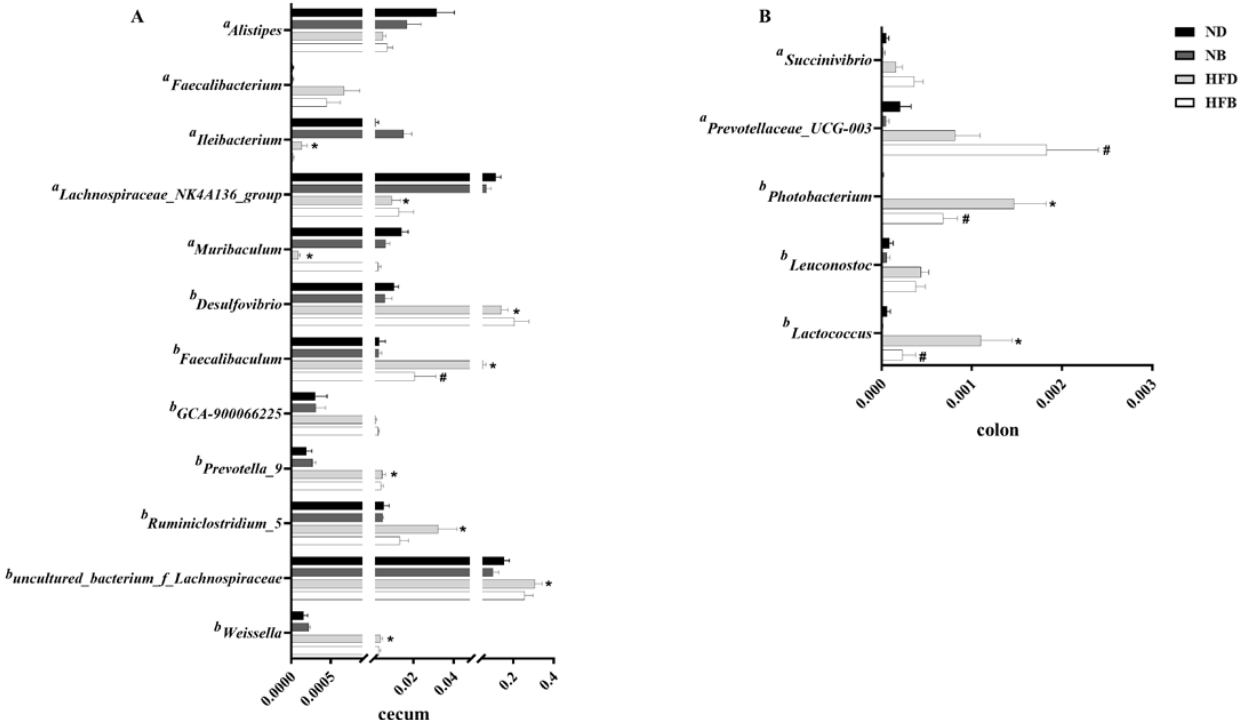
Figure 7. BCAA supplementation alters gut microbiota relative abundance in ApoE − / − mice. The relative abundance of gut microbiota at the genus level in the cecum ( A ) and colon ( B ) The data are presented as the mean ± SEM ( n = 4–5 for each group). Letters “a” and “b” indicate possible probiotics and pathogenic bacteria previously reported, respectively. * p < 0.05 vs. ND group; # p < 0.05 vs. HFD